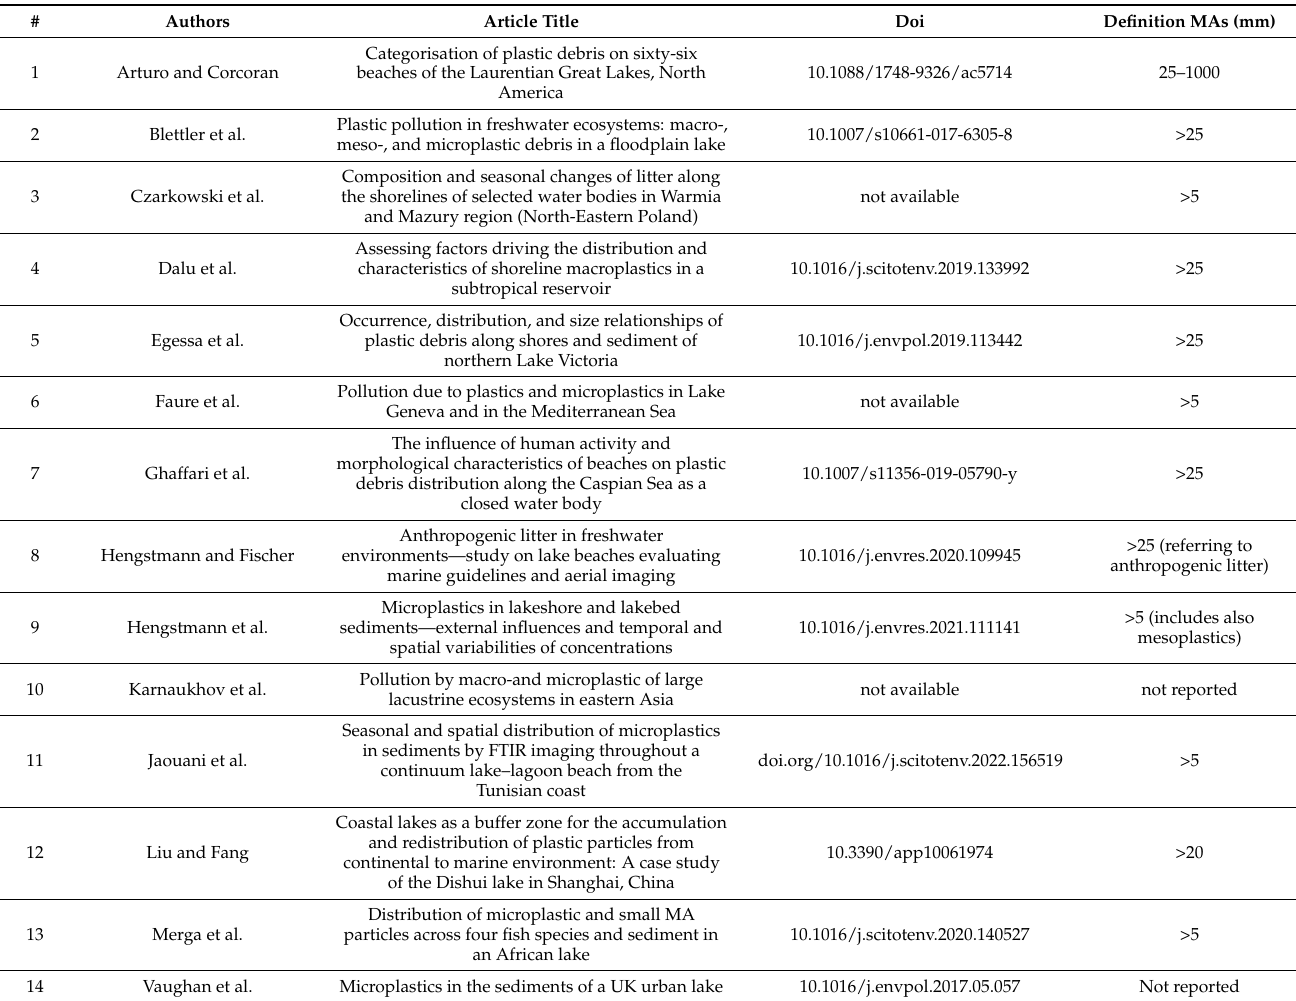
Table 1. List of scientific articles tackling the issue of MAs in lakes. Information on MA size definition and abundance is reported, according to the unit of